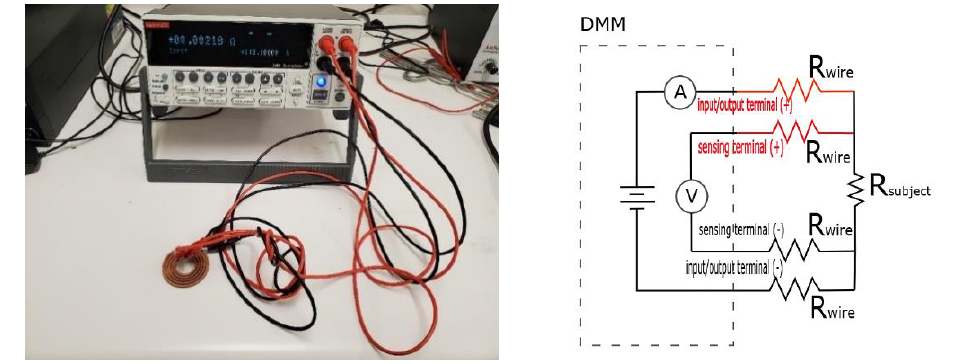
Figure 20. Electrical resistivity measurement of Cu coil made by L-PBF .